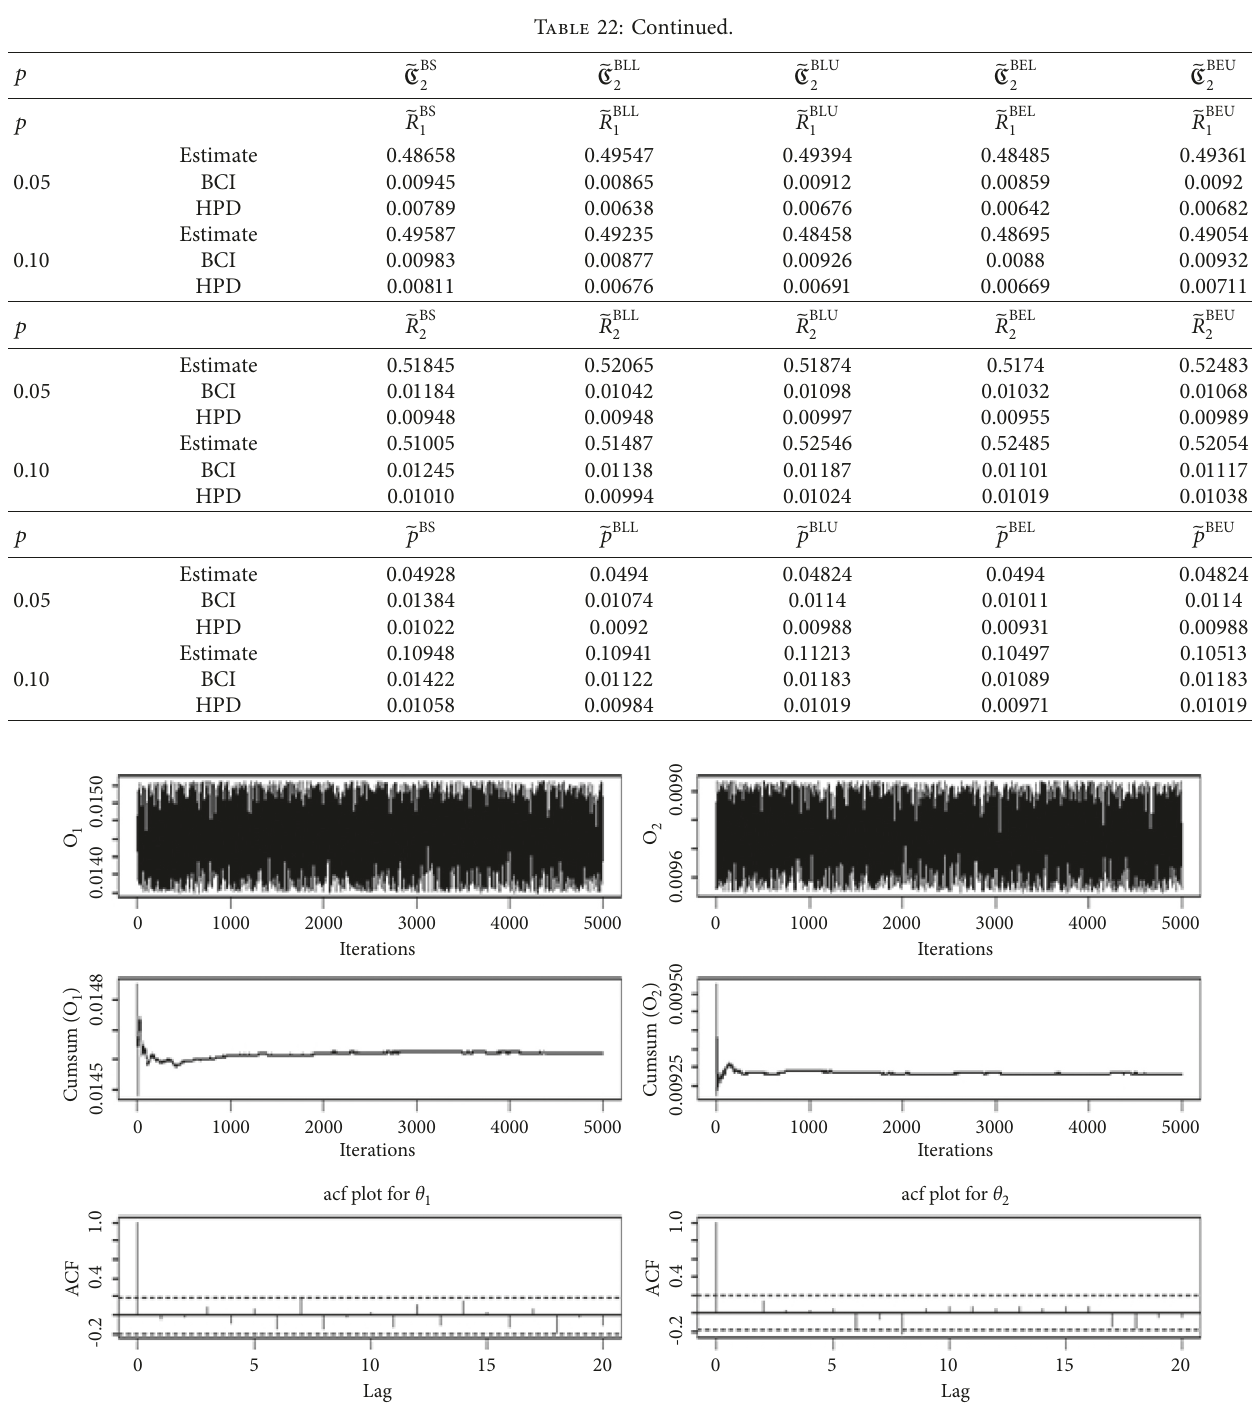
Figure 1: The iteration Cusum and acf plot for θ